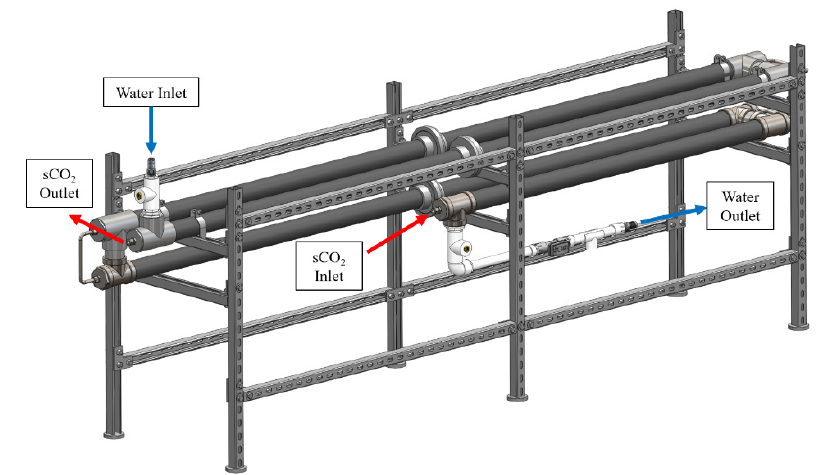
Figure 13. Heat exchanger